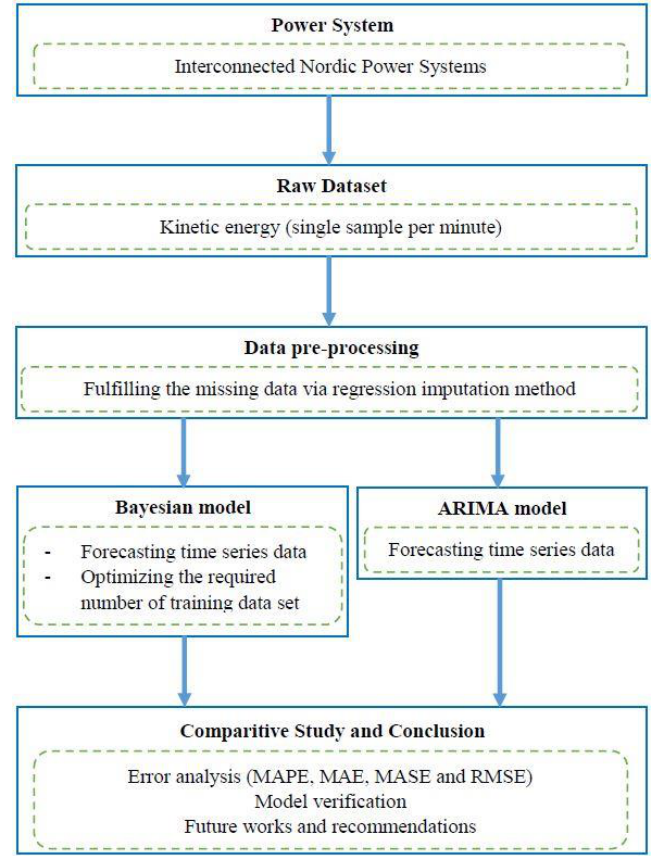
Figure 1. Adopted workflow.